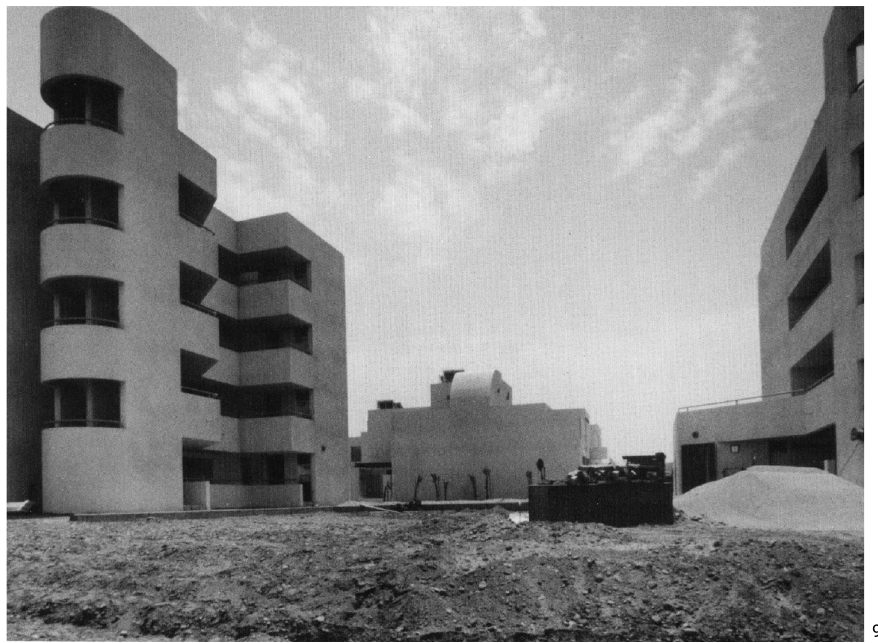
CRS residential housing in Yanbu demonstrates human-scaled regionally inspired form. In their repetitive plan-form and accretive mor- phologies, housing formed the crux of the flexible city making by which Jubail and Yanbu would develop. Source: Charles E. Lawrence, Saudi Search (Houston, TX: CRSS Research Division):